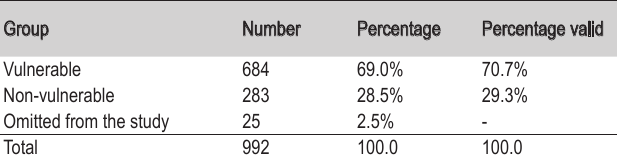
Table 2 - Results of cluster analysis using data of 992 study participants in